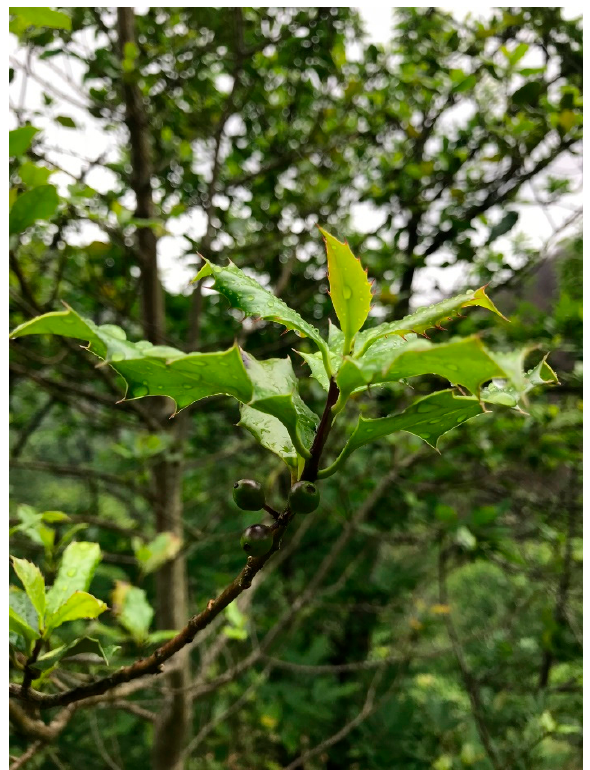
Figure 1. Ilex aquifolium from Margaraça (Arganil, central Portugal).